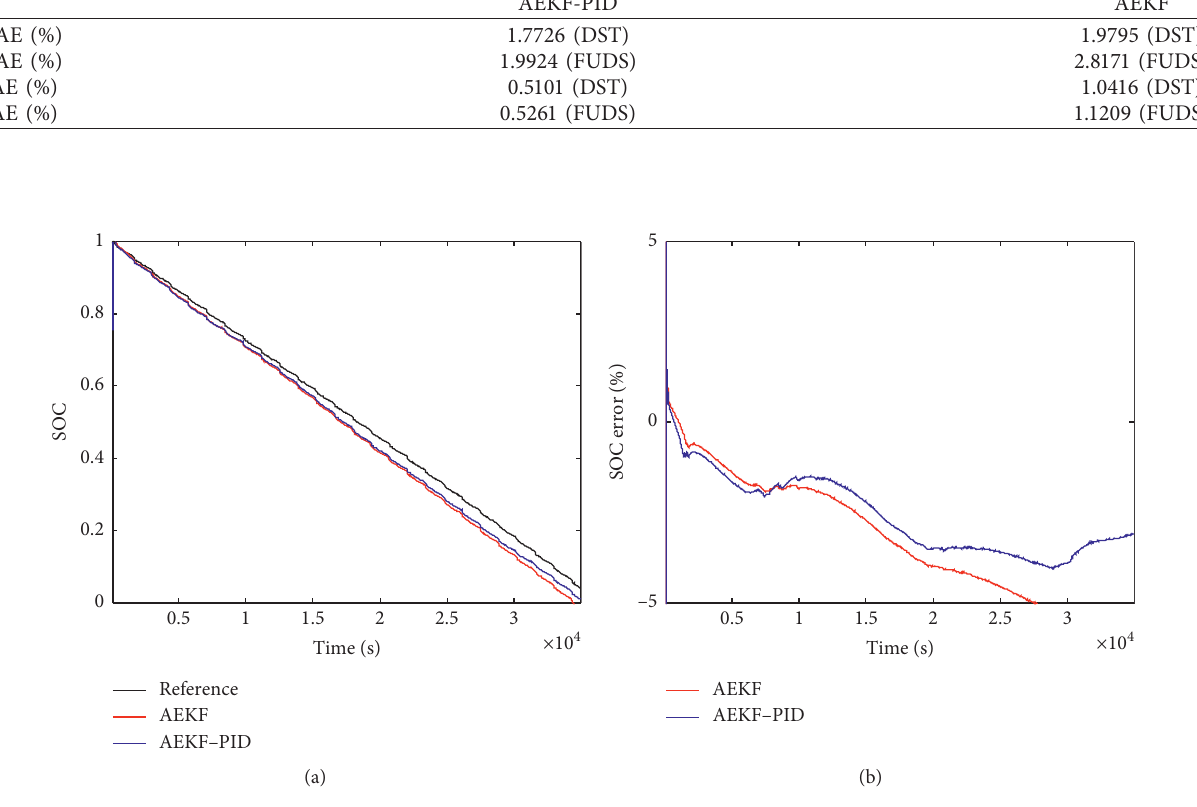
Figure 15: Comparison of SOC estimation with non-Gaussian noise: (a) SOC estimation result; (b) SOC estimation error.